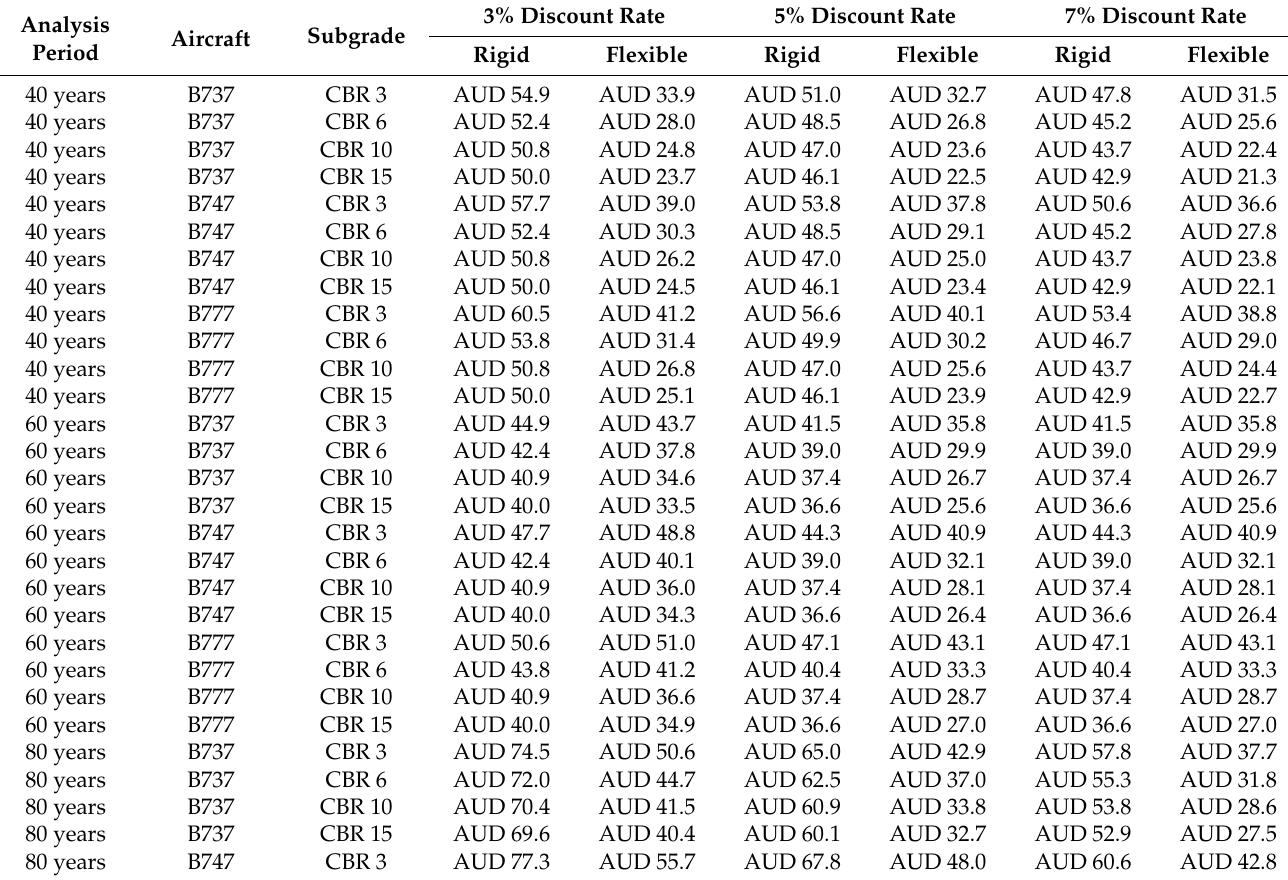
Table A1. Whole of Life Costs (millions) for different analysis periods and discount